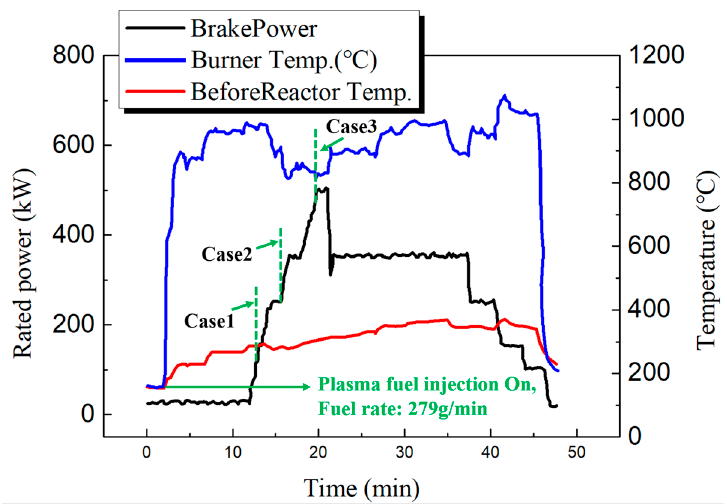
Figure 8. Combustion pattern as load change.